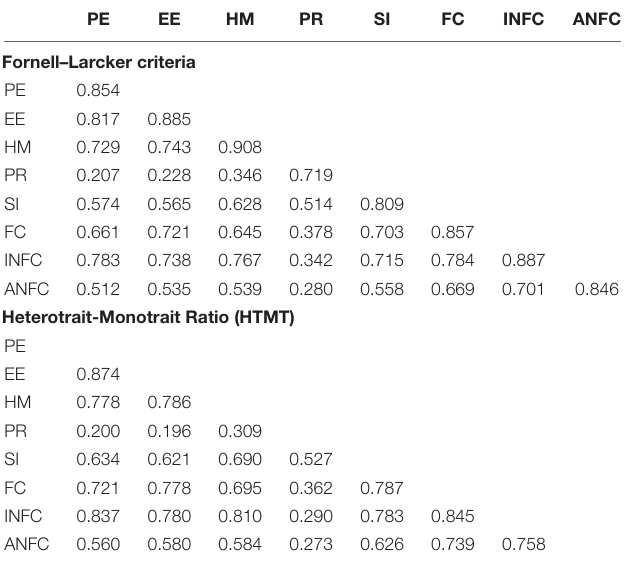
TABLE 3 | Discriminant validity of constructs.